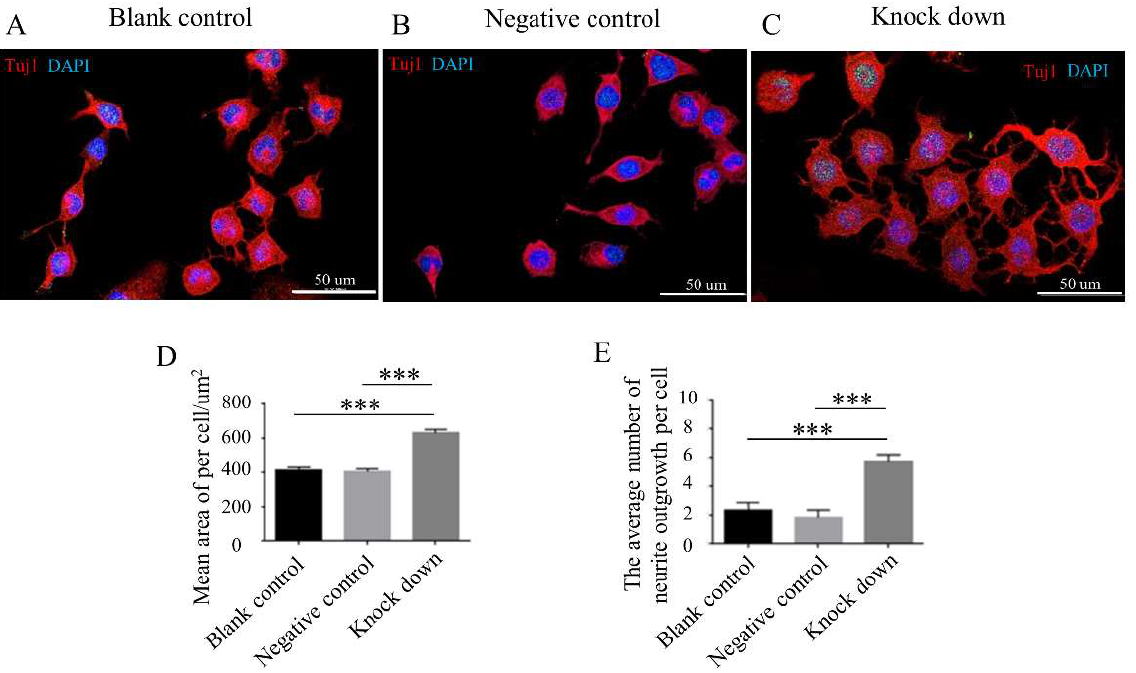
Figure 4. Comparison of neuron polarity among different N-2a cell groups. ( A – C ) Double im- munofluorescent labeling (Tuj1) of N-2a cell lines. ( D , E ) Comparison of mean area of per cell/um 2 and amount of neurite outgrowth per cell in different groups. ***, p < 0.001, one-way ANOVA with Bonferroni post hoc, n = 3. Knockdown, infected with Doc2a -lentivirus; negative control, Lentivirus Luciferase Reporter negative control; blank control, cultured with an equal medium.